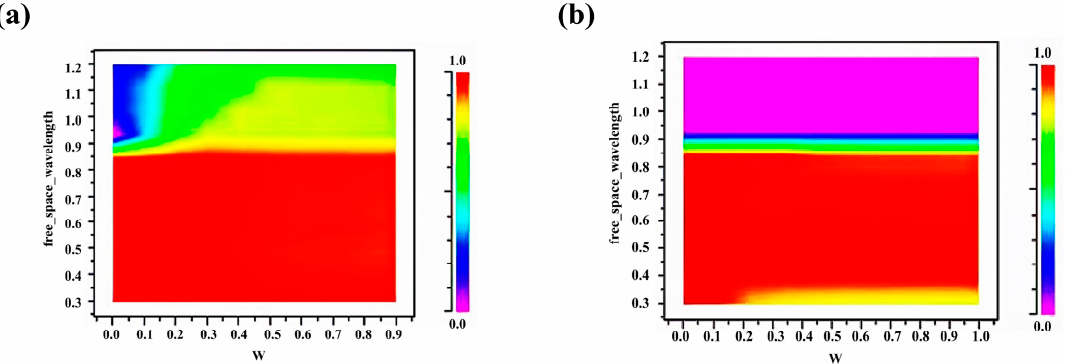
Figure 3. ( a ) The dependance of the absorption efficiency of the absorption layer with KNbO 3 column hexagon scatterers on side length W. ( b ) The dependance of the absorption efficiency of the absorption layer with the air-hole hexagon scatterers on side length W.